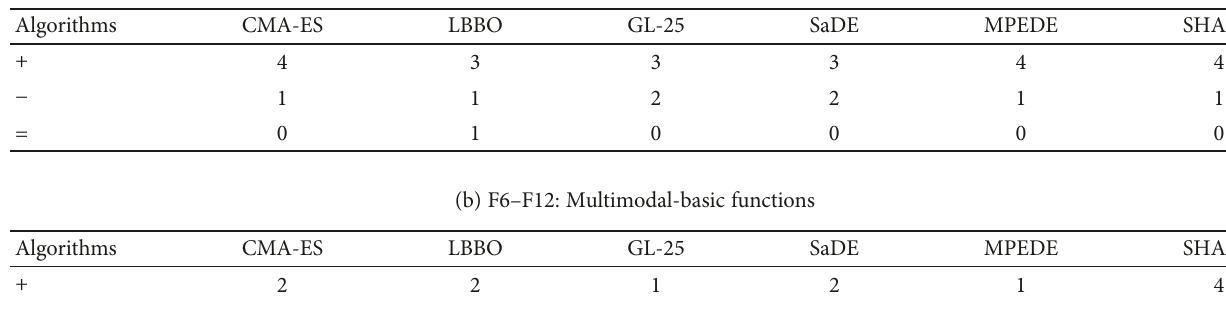
Table 10: Comparison between DEMR and other algorithms on di ff erent types of functions.